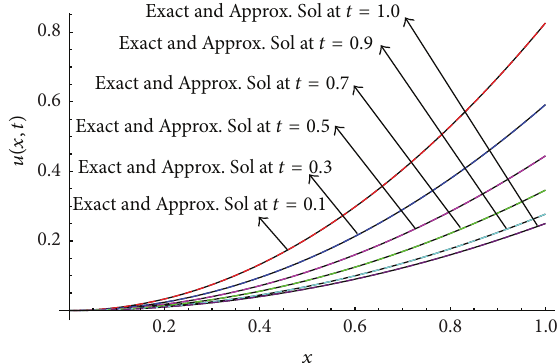
Figure 4: A comparison of numerical solution and known solution at different time levels for Example 2 with ℎ = 0.05 and 𝑘 = 0.01 .